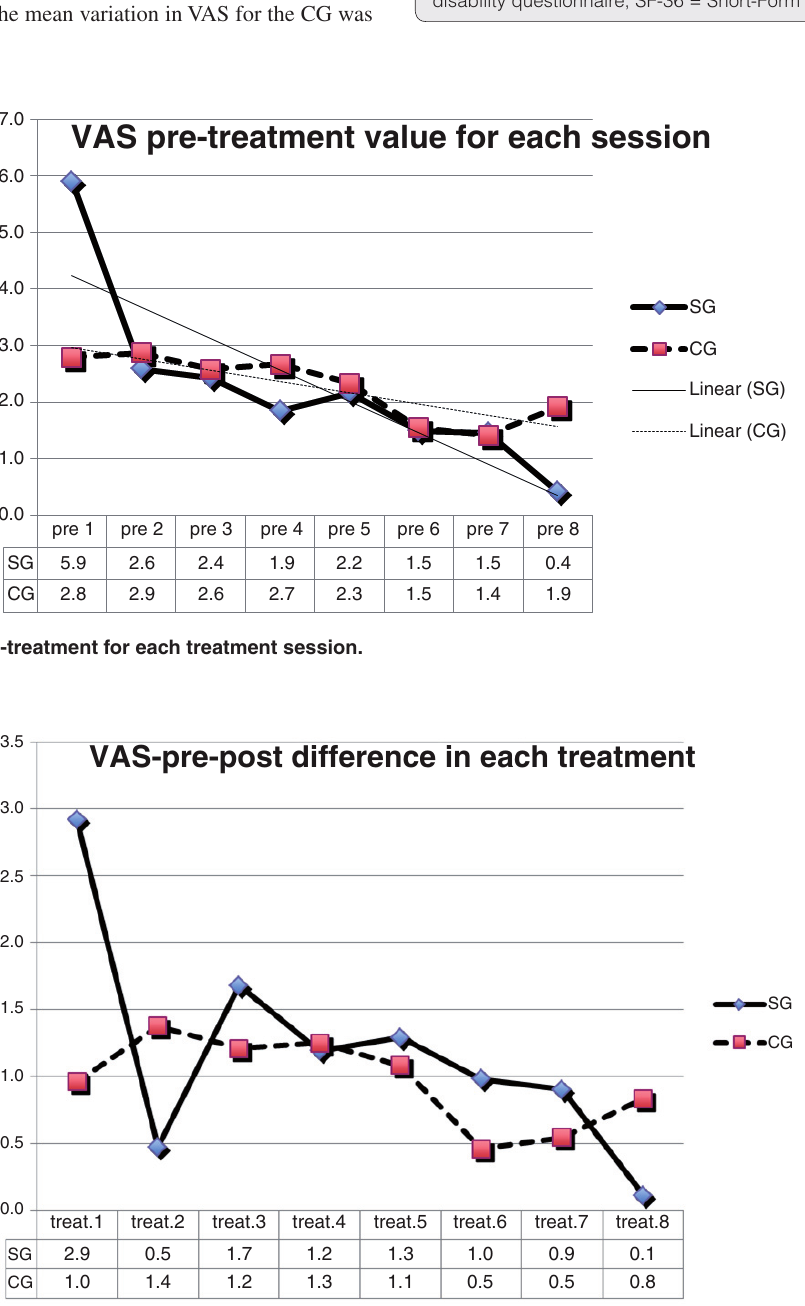
Figure 3. Mean differences in VAS for each treatment